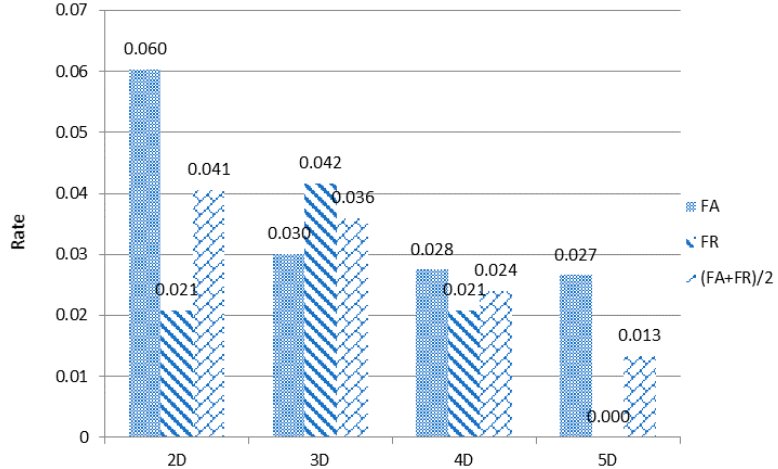
Figure 8. FA/FR rates from 2D to 5D.